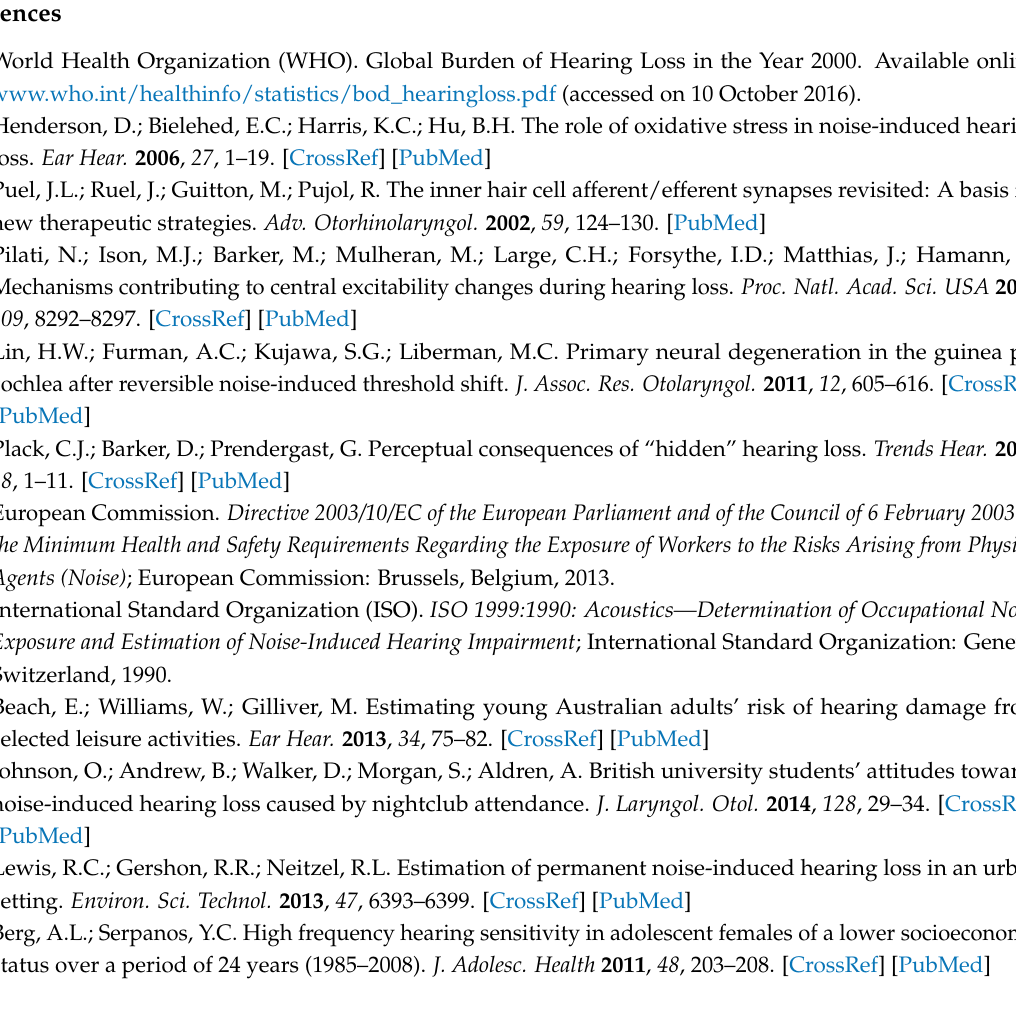
Table S1: Individual studies had to meet the following criteria in order to be included in the evidence review. If the criteria were adjusted, a justification is given detailing the reasons, Table S2: The template for assessment of quality and risk of bias, Table S3: GRADE for quality of evidence from personal listening devices associated with hearing impairment and tinnitus, Table S4: The template for assessment of quality and risk of bias of individual studies, Table S5: The list of included and excluded